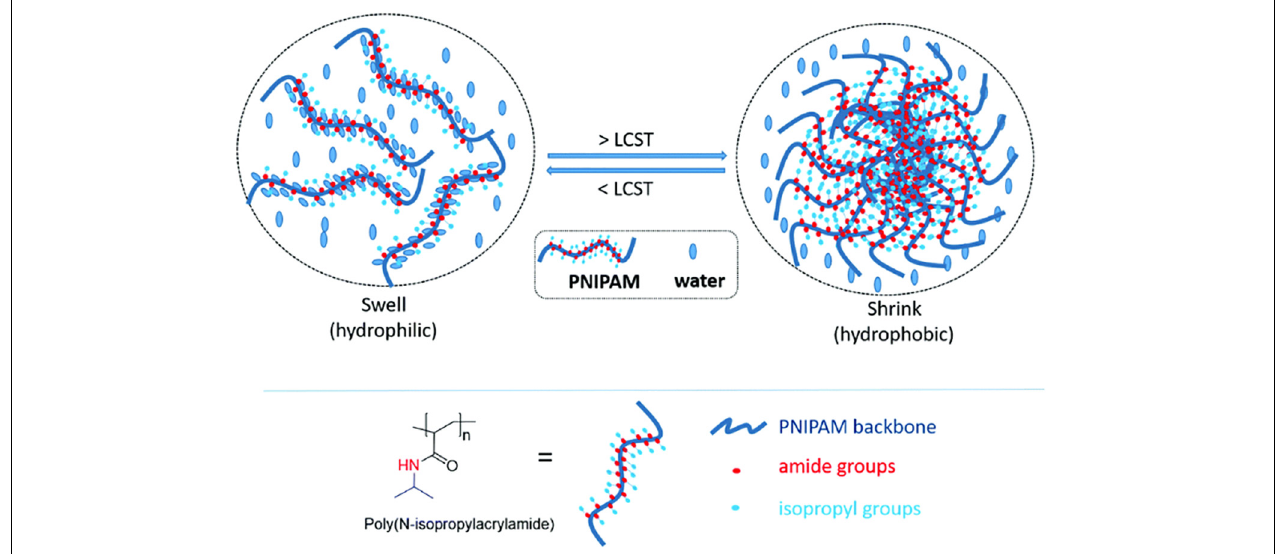
FIGURE 3 | Schematic illustration of the chemical structure and thermo-gelling LCST behavior of PNIPAAm. Reproduced with permission from the Royal Society of Chemistry, Doberenz et al.